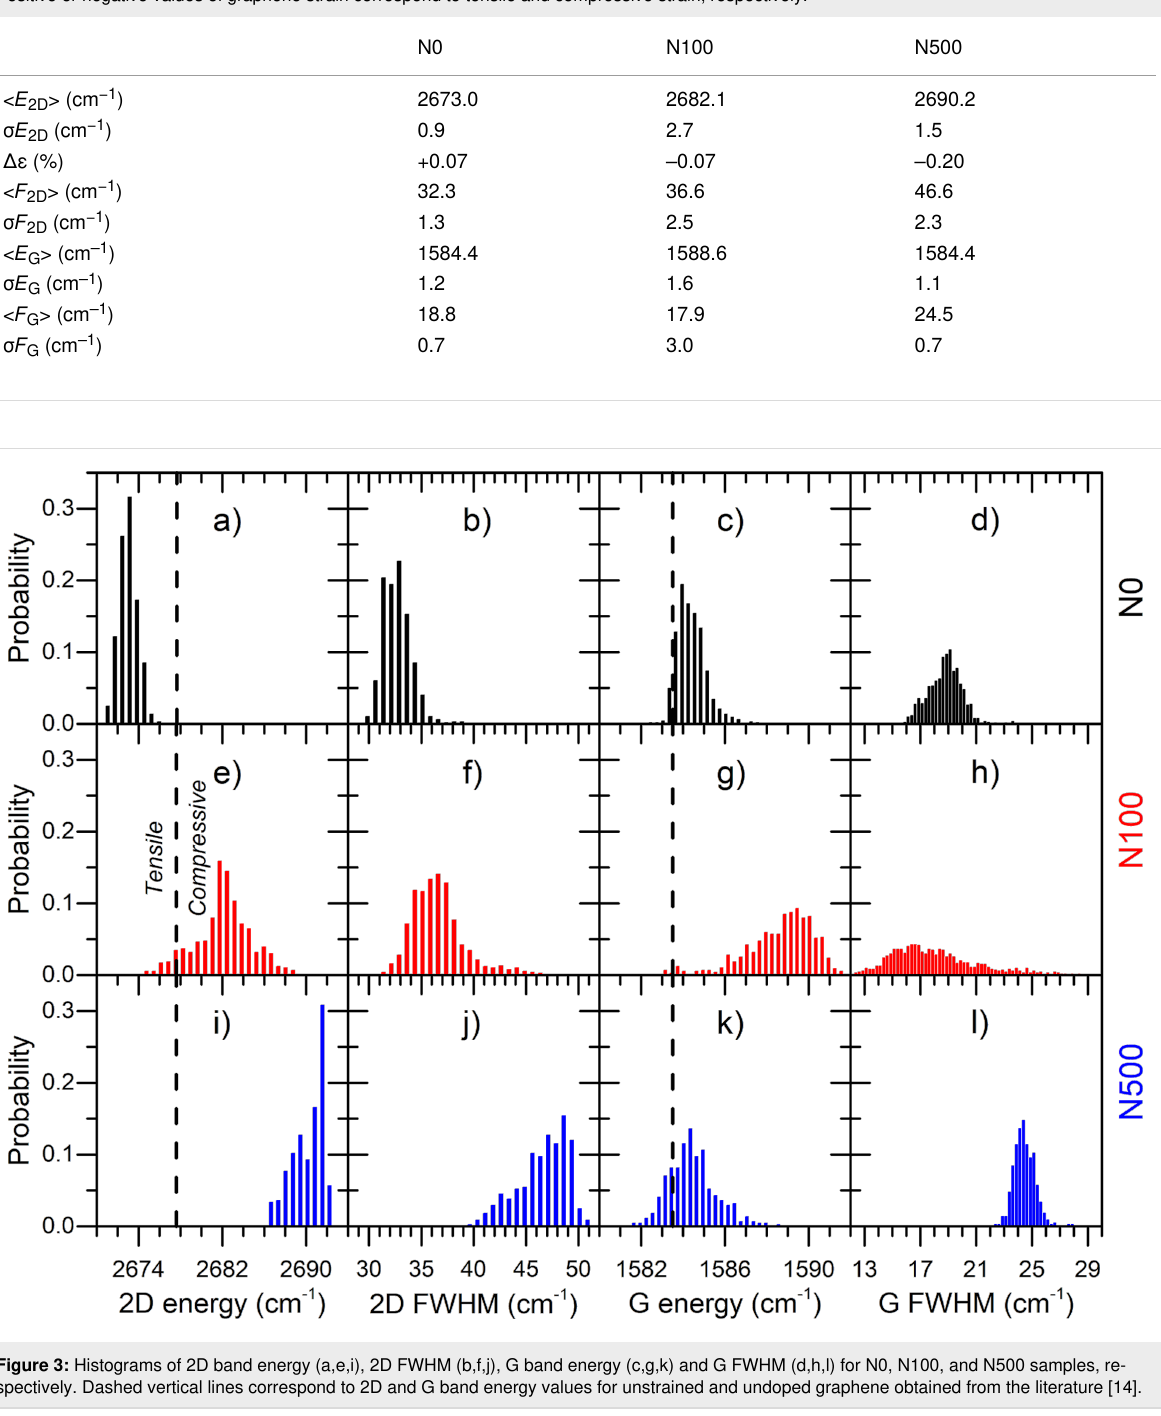
Table 2: Average 2D and G band energy values (< E 2D > and < E G >) with their standard deviation ( σ E 2D , σ E G ), 2D and G band FWHM (< F 2D > and < F G >) with their standard deviation ( σ F 2D , σ F G ) and calculated value of the average strain ( Δε ) in graphene on NWs with different variations in height. Positive or negative values of graphene strain correspond to tensile and compressive strain, respectively.